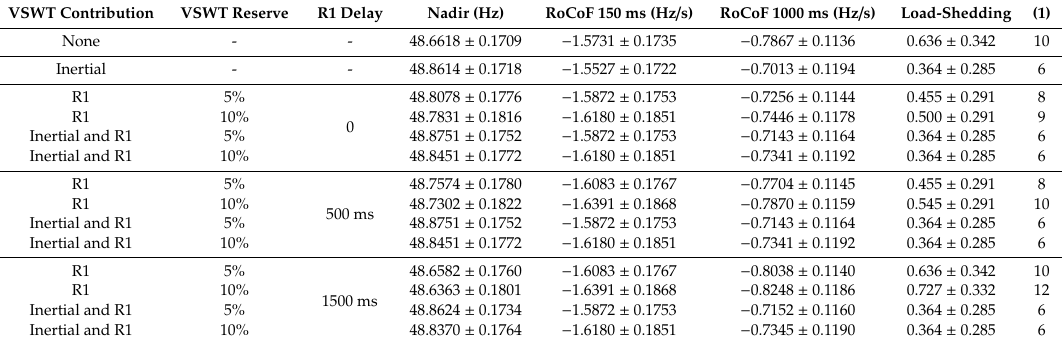
Table 7. Average of nadir, Rate of Change of Frequency (RoCoF) and load-shedding amount and (1) number of schedules in which at least one load-shedding step is needed, considering di ff erent VSWT contributions when the biggest operating unit outage takes